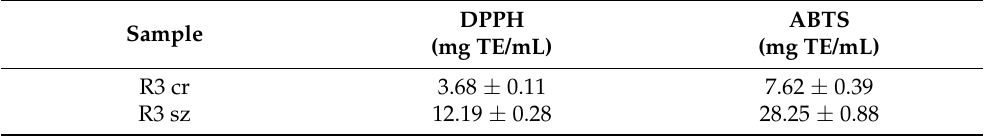
Table 4. TPC, TFC and antioxidant activity of investigated extracts.